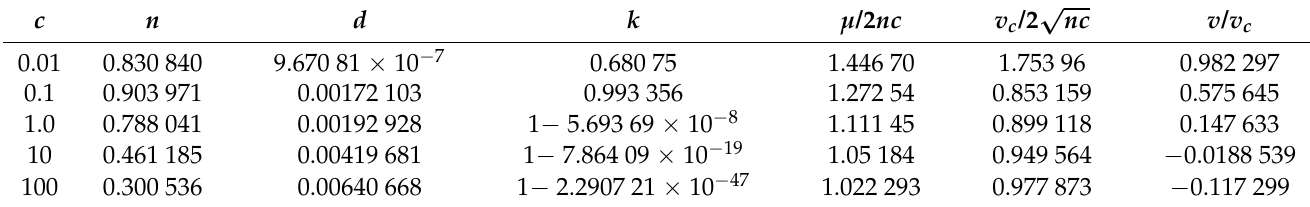
Table 1. Parameters of the profiles of the elliptic solutions in Figures 4 and 5. The notch depth d is given by the minimum of the square amplitude profile for each value of c . Here, for c = 0.01, n = 0.830 840 denotes n = 0.830 840.